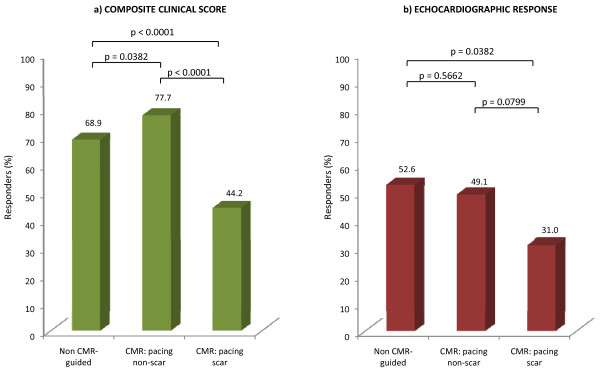
Symptomatic and echocardiographic response according to implantation strategy. Numbers refer to the proportion of patients meeting the respective endpoints by the end of the study.